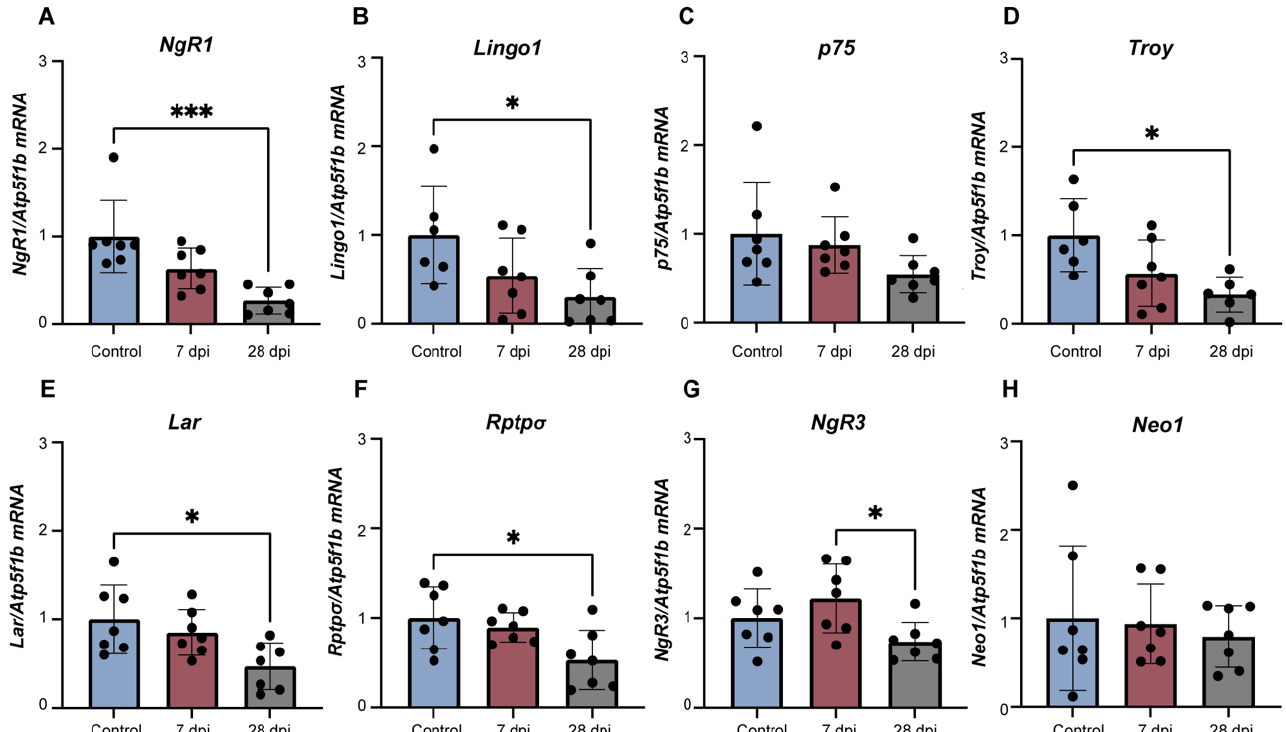
Figure 4. Levels of mRNA of myelin-associated inhibitors (MAI) receptor complex NgR1 ( A ), Lingo1 ( B ), p75 ( C ) and Troy ( D ), CSPGs receptors Lar ( E ), Rptp σ ( F ) and NgR3 ( G ) ; and RGMa receptor Neo1 ( H ) in lumbosacral (L5-S1) DRG of spinal intact (control) and SCT animals. After thoracic spinal cord transection, mRNA levels of receptor complex NgR1 / Lingo1 / p75 ( A – C ) and/or Troy ( D ) tended to significantly decrease 28 dpi (days post-injury). Lar / Rptp σ / NgR3 ( E – G ) also followed the same trend. RGMa receptor Neo1 mRNA levels ( H ) were not changed by the thoracic spinal cord lesion. Graphs represent mean ± SD and p < 0.05 was considered statistically significant. * p ≤ 0.05; *** p ≤ 0.001; one-way ANOVA followed by Tukey’s multiple comparison test.